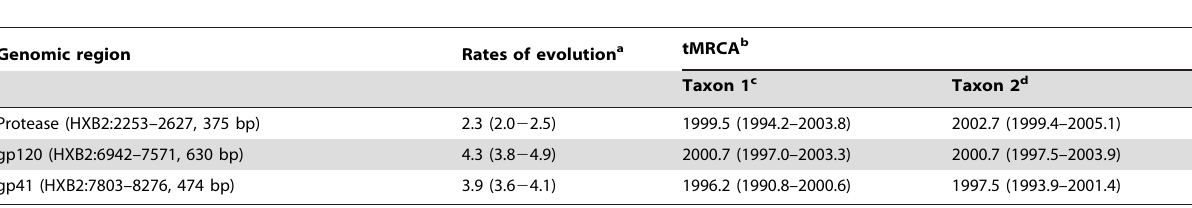
Table 1. Evolutionary characteristics of HIV-1 CRF51_01B isolates from Singapore and